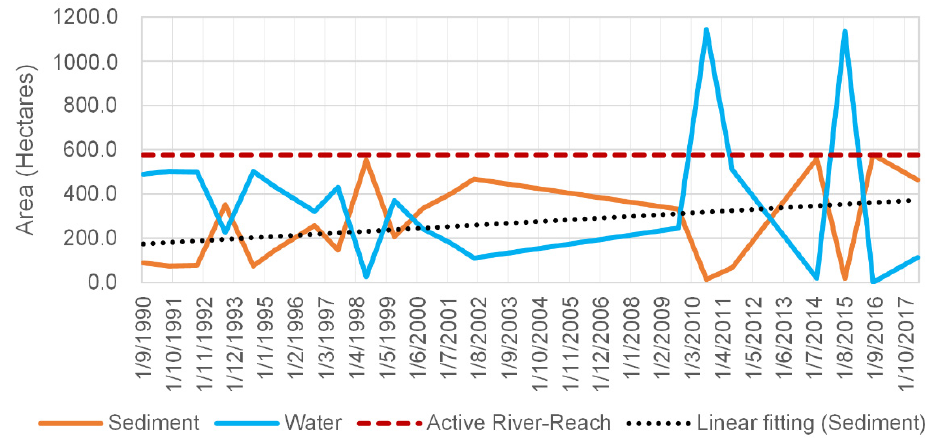
Figure 3. NDWI analysis of the study river-reach using Band 2 (Green) and Band 4 (NIR) of Landsat imagery from 1990 to 2018.